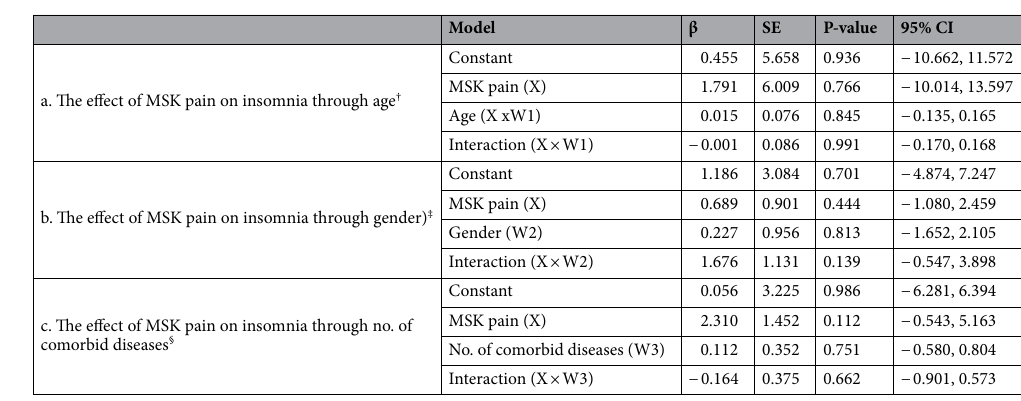
Table 5. The relationship between MSK pain and insomnia through the moderators (n = 498) ^. ^Abbreviations: β, beta coefficient; SE, standard error; CI, confidence interval; BMI: Body Mass Index; MSK: Musculoskeletal; † Adjusted for gender, BMI, no. of comorbid diseases and insomnia at baseline; ‡ Adjusted for age, BMI, no. of comorbid diseases and insomnia at baseline; § Adjusted for age, gender, BMI and insomnia at baseline.